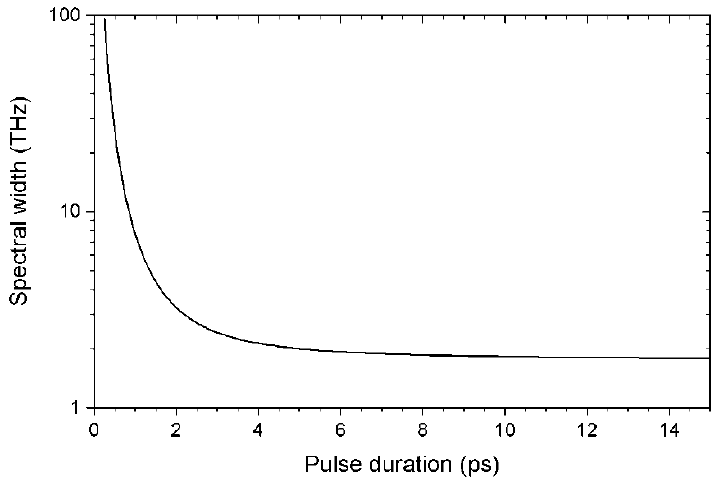
Figure 4. The estimated SPM-induced spectral broadening as a function of pump pulse duration. The pulse energy was 210 μ J and the pressure of D 2 was 5 atm.